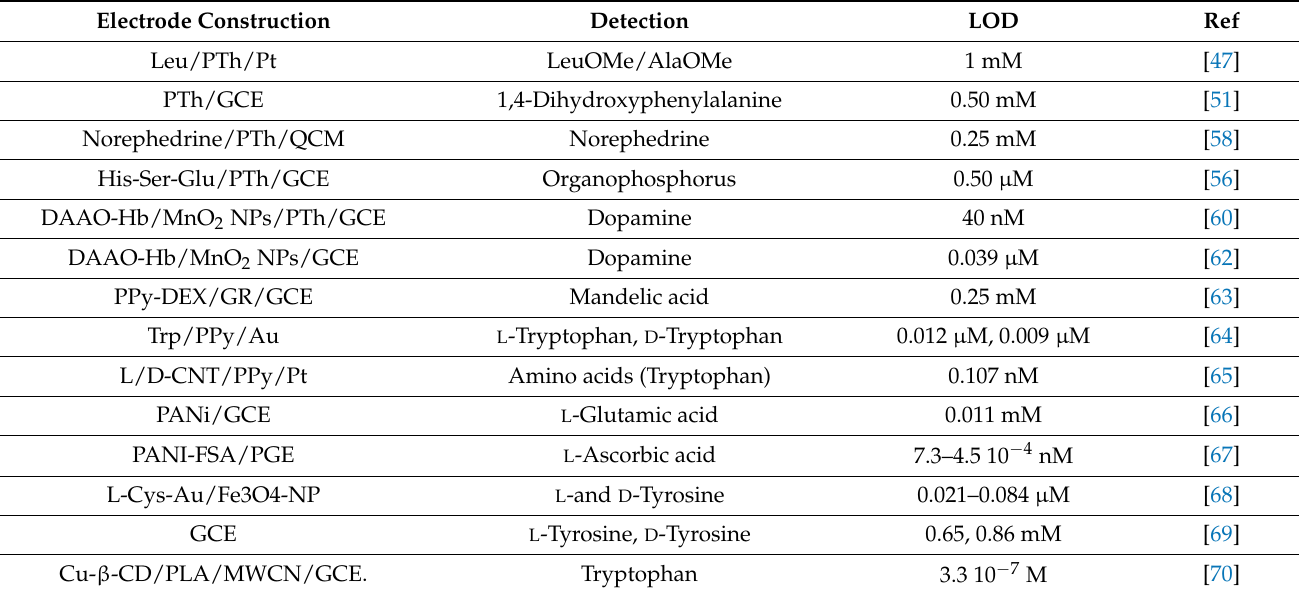
Table 1. Examples of electrochemical chiral electrode